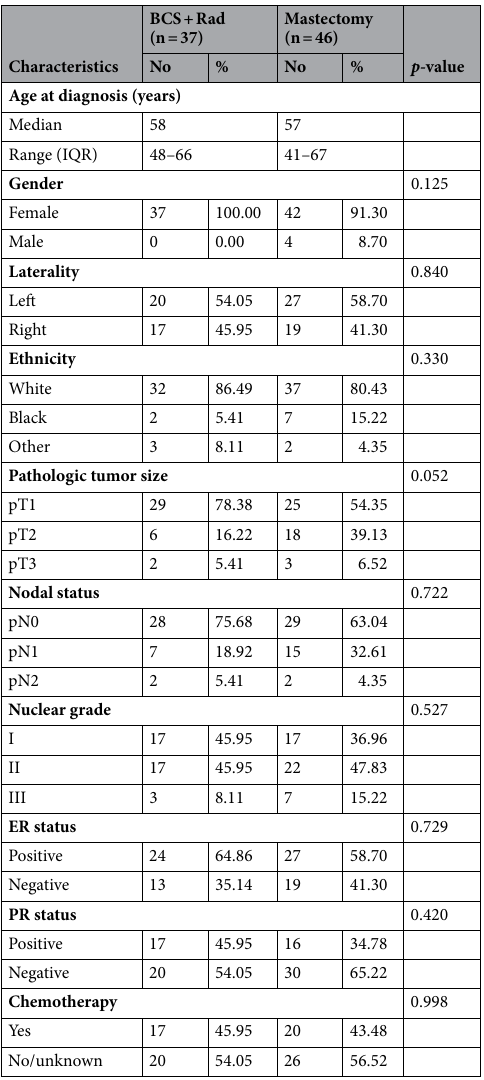
Table 2. Clinicopathologic characteristics and chemotherapy of subgroups divided by type of surgery. pT1 pathological tumor size ≤ 2 cm, pT2 2 cm < pathological tumor size ≤ 5 cm, pT3 pathological tumor size > 5 cm, III poor differentiation, ER estrogen receptor, PR progesterone receptor, BCS breast conserving